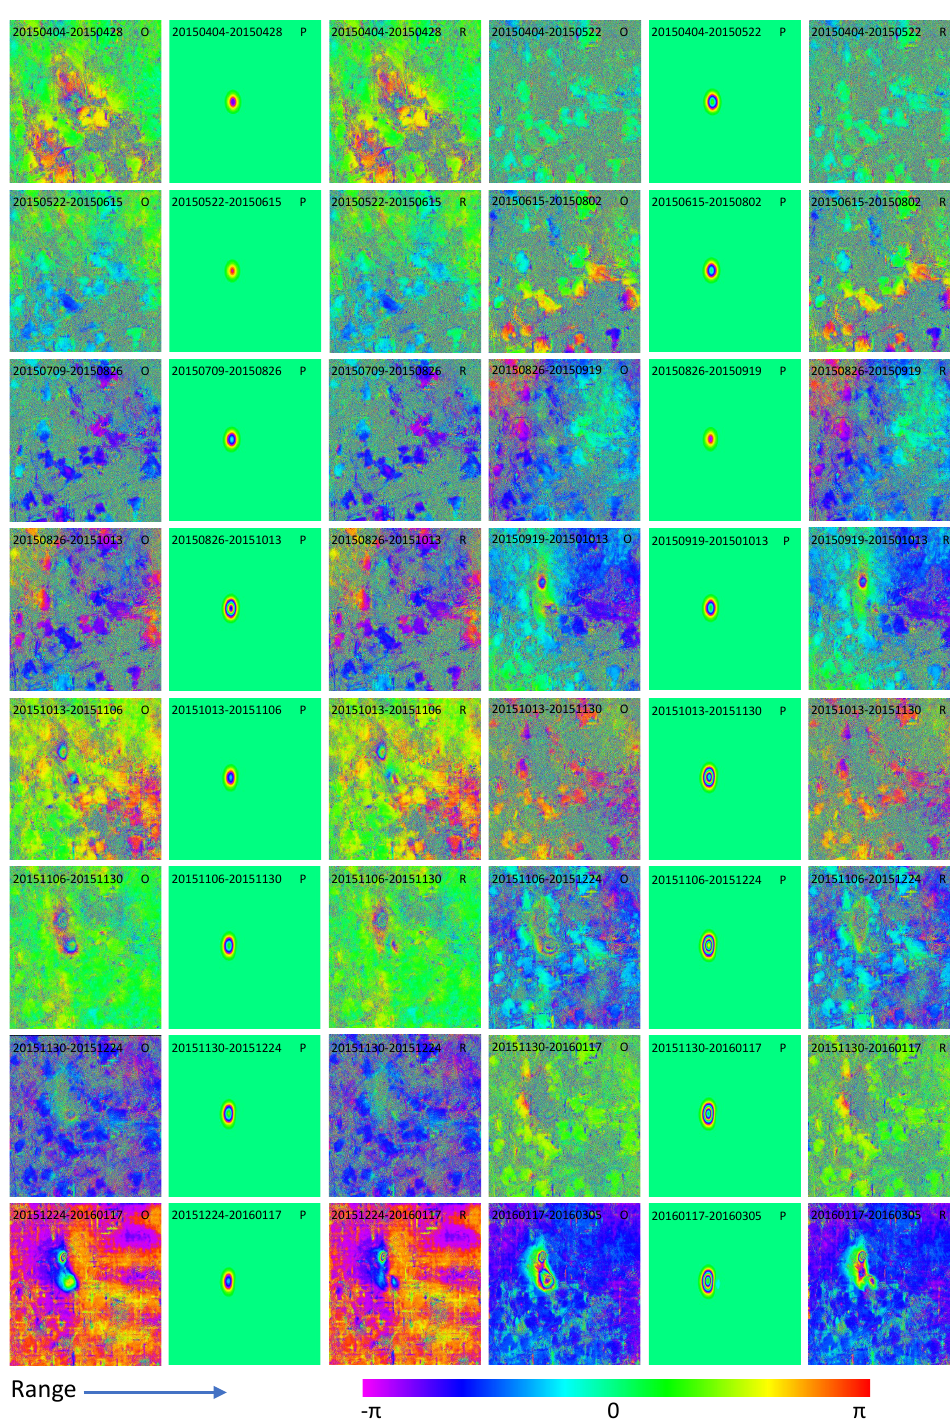
Figure 4. Phase maps of 16 original interferograms, model-simulated deformation, and residual interferograms in image coordinates: The acquisition dates of master image and slave image of each interferogram is on the top; O indicates original interferogram, P means the phase map derived from PIM model, and R represents the residual interferogram. For each interferogram, the vertical axis is azimuth direction and the horizontal axis is